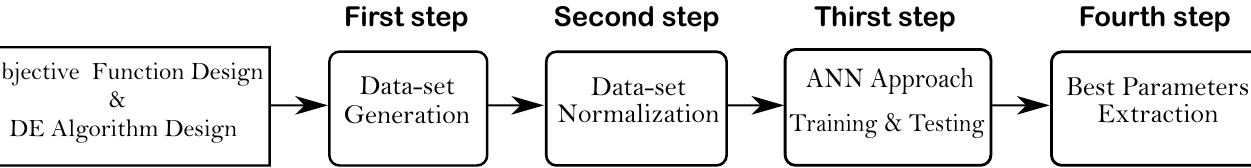
Figure 2. The block diagram of the proposed method. The method is applied once the objective function and DE algorithm are designed. Each step is executed just one time for each objective function. As a result of this method, the optimal DE parameters (NP, F and CR) are obtained for each objective